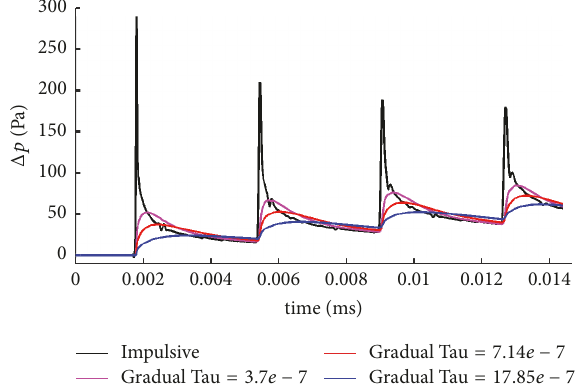
Figure 11: Pressure history at the center of the domain for 𝜏 ℎ values 0, 𝜏 , 2𝜏 , and 5𝜏 .